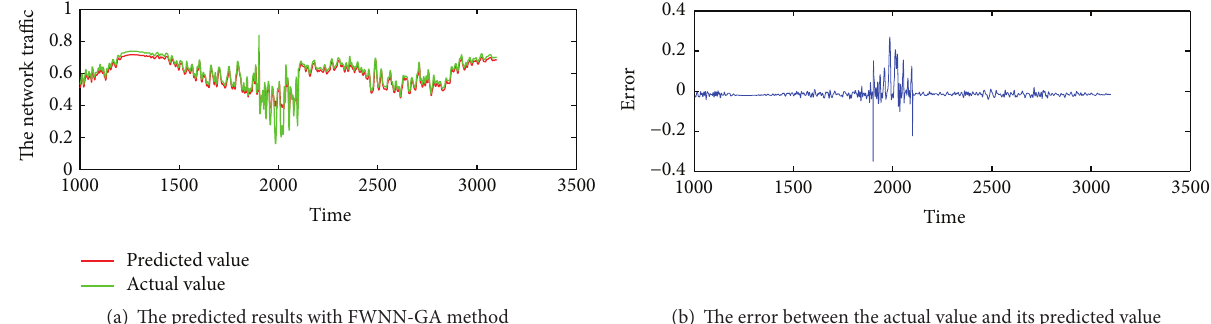
Figure 9: Prediction results with FWNN-GA method.